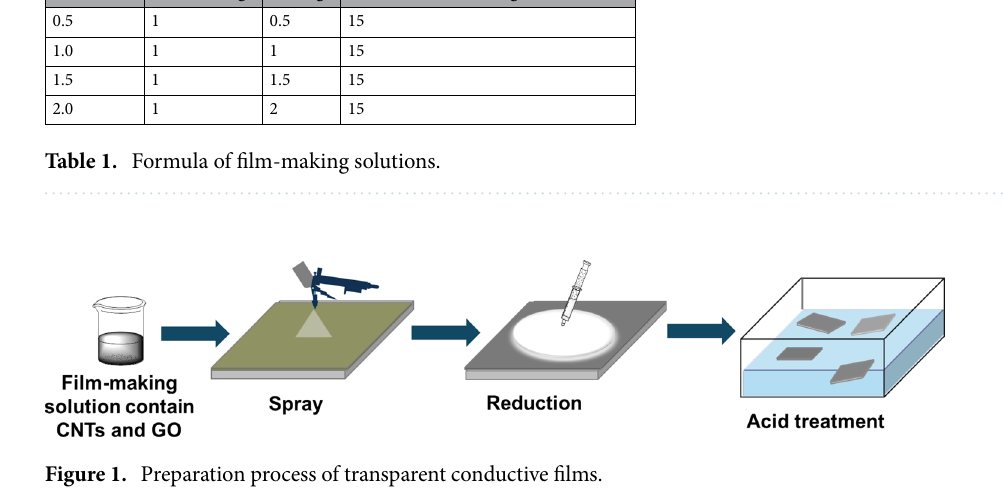
Figure 1. Preparation process of transparent conductive